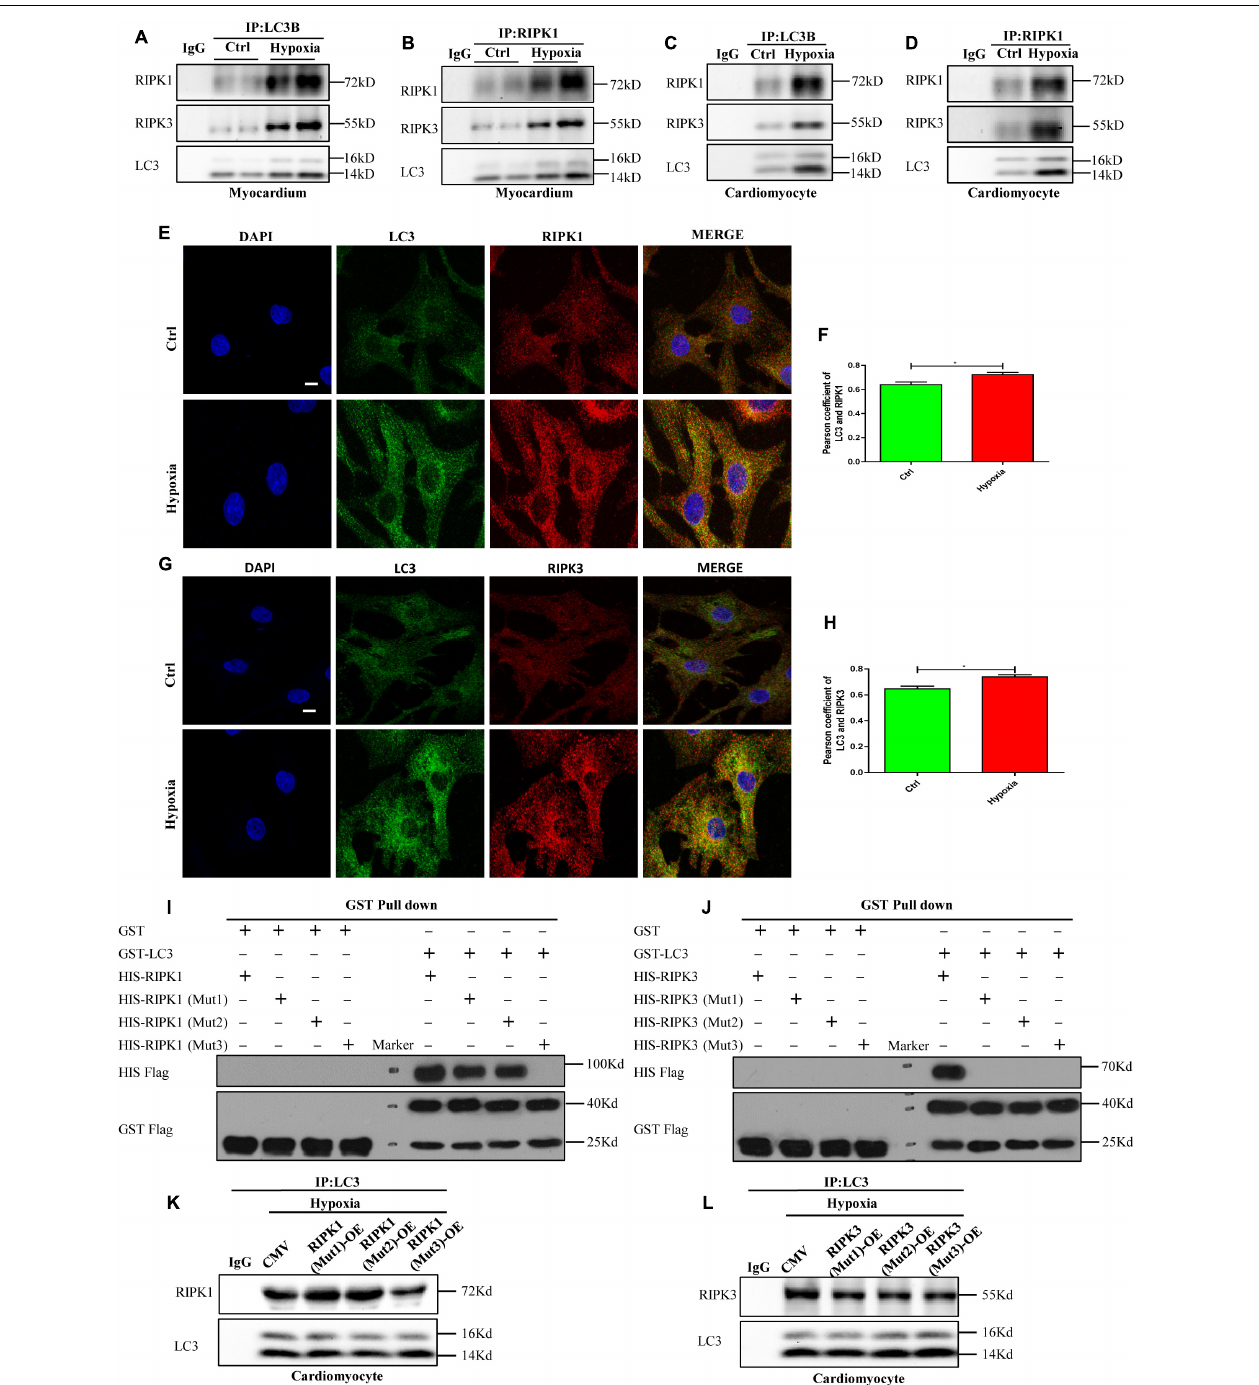
FIGURE 4 | Autophagosome accumulation-induced LC3 overexpression provides a spatial platform for necrosome formation by direct interaction with RIPK1 and RIPK3. (A,B) The myocardium was lysed and immunoprecipitated with anti-LC3 or anti-RIPK1 antibodies followed by immunoblotting with anti-LC3, anti-RIPK1 or anti-RIPK3 antibody ( n = 3). (C,D) The cardiomyocytes were lysed and immunoprecipitated with anti-LC3 or anti-RIPK1 antibodies, followed by immunoblotting with anti-LC3, anti-RIPK1 or anti-RIPK3 antibody ( n = 3). (E,F) Representative confocal images and statistical analysis of Pearson coefficient of co-localizing RIPK1 (red) and LC3 (green) in cardiomyocytes. Mean ± SEM, n = 3. * p < 0.05 versus control group. Scale bar, 10 µ m, n = 3. (G,H) Representative confocal images and statistical analysis of Pearson coefficient of co-localizing RIPK3 (red) and LC3 (green) in cardiomyocytes. Mean ± SEM. * p < 0.05 versus control group. Scale bar, 10 µ m, n = 3. (I,J) The GST pull-down assay was performed with GST, GST-LC3, His-RIPK1, and His-RIPK3, before or after LIR domains were mutated. (K,L) The cardiomyocytes were lysed and immunoprecipitated with anti-LC3 antibodies, followed by immunoblotting with anti-LC3, anti-RIPK1 or anti-RIPK3 antibody ( n = 3).